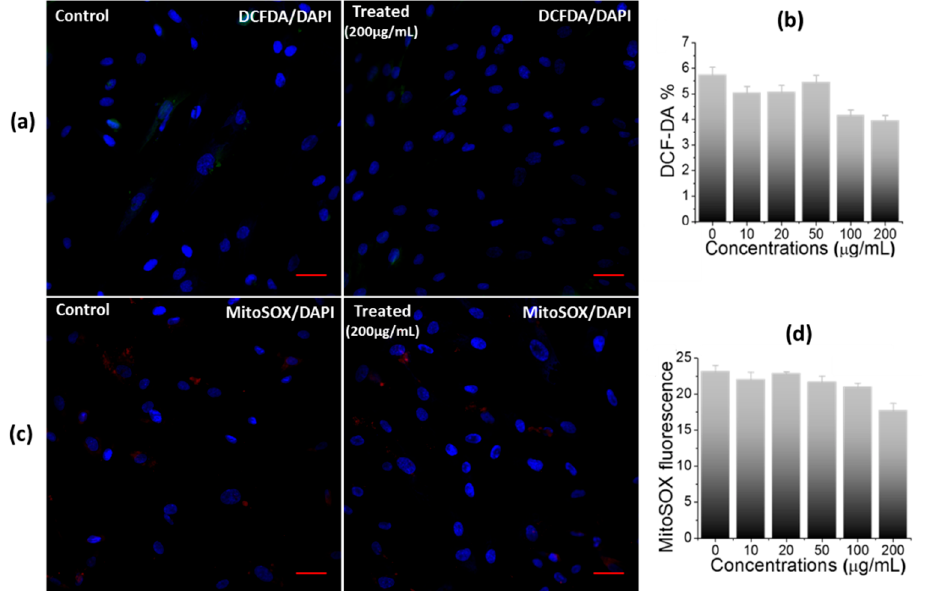
Figure 6. Impact of nanosheets treatment on oxidative stress in hWJ-MSCs. ( a ) Confocal images, ( b ) Quantitative estimation of DCF-DA stained control and treated cells (200 µg/mL), showing no oxidative stress, ( c ) Confocal images, and ( d ) Quantitative estimation of MitoSOX-stained control and treated cells, indicating non-significant generation of mitochondrial superoxide in treated cells (scale bar: 50 µm).